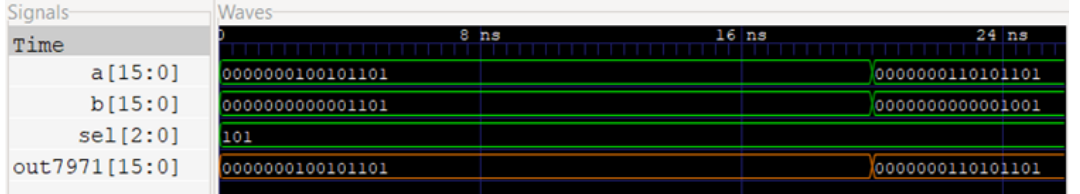
Figure 16. Circuit for the bitwise OR generated through Verilog.